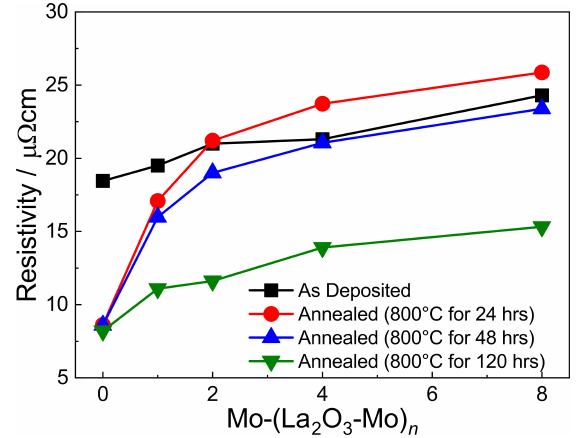
Figure 8. Determined resistivity of the 100 nm thick Mo and Mo-(La 2 O 3 -Mo) n thin film systems on SiO 2 /Si based on the measured sheet resistances using the van der Pauw